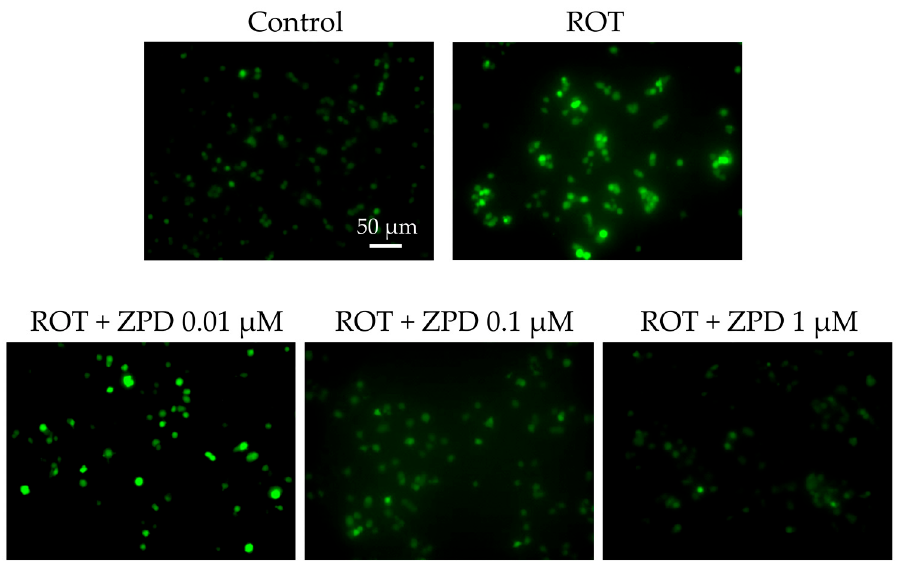
Figure 5. E ff ect of ziprasidone (ZPD) on rotenone (ROT)-induced reactive oxygen species (ROS) generation. Representative images showing the preventive e ff ect of ZPD against ROT-induced ROS production. Scale bar: 50 μ m.